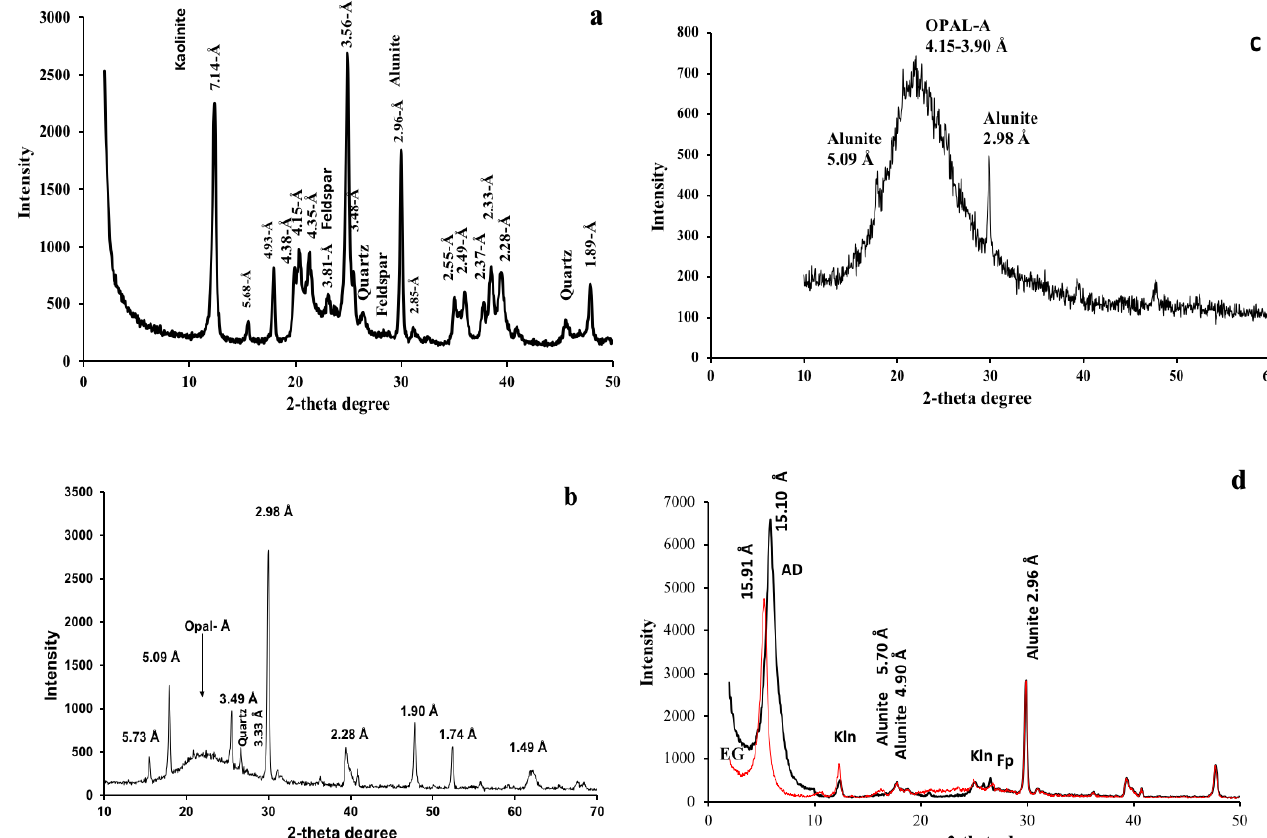
Figure 3. XRD patterns of randomly oriented aggregates: ( a ) kaolinite — alunite assemblage (quartz and K-feldspar traces); ( b ) alunite — opal-A assemblage; ( c ) sinter constituted by opal-A + alunite assemblage. ( d ) XRD pattern of oriented clay aggregates (<2 µm clay fractions, sample Mud clays) of smectite + kaolinite + alunite assemblage. AD: air-dried; EG: ethylene glycol.